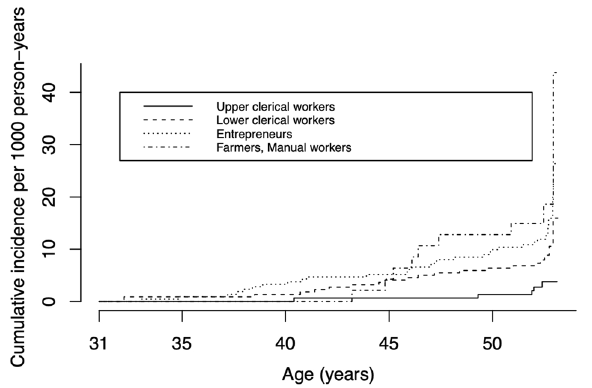
Figure 2. Cumulative incidence of hospitalization due to ulnar nerve entrapment (UNE) in different socio- economic groups over follow-up period. One individual was diagnosed with UNE before baseline in 1997.